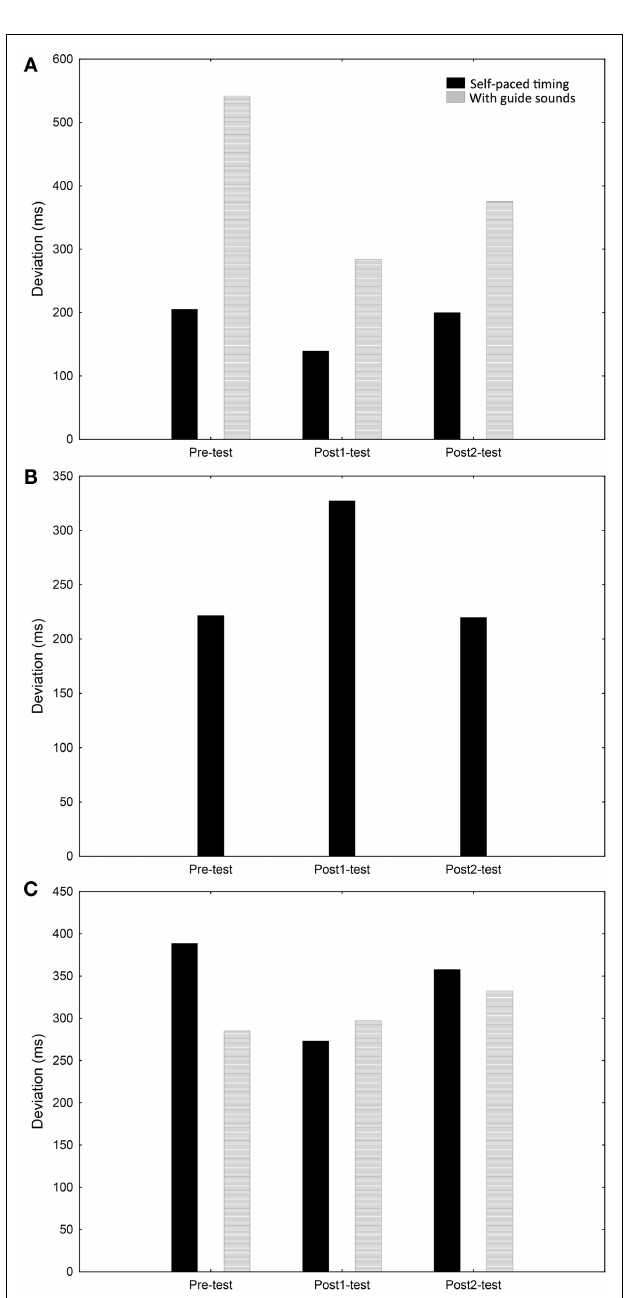
FIGURE 3 | Rhythmic and timing performance (self-paced and with guide sounds) for case I (A), case II (B), and case III (C) at the Pre, Post1, and Post2 occasions